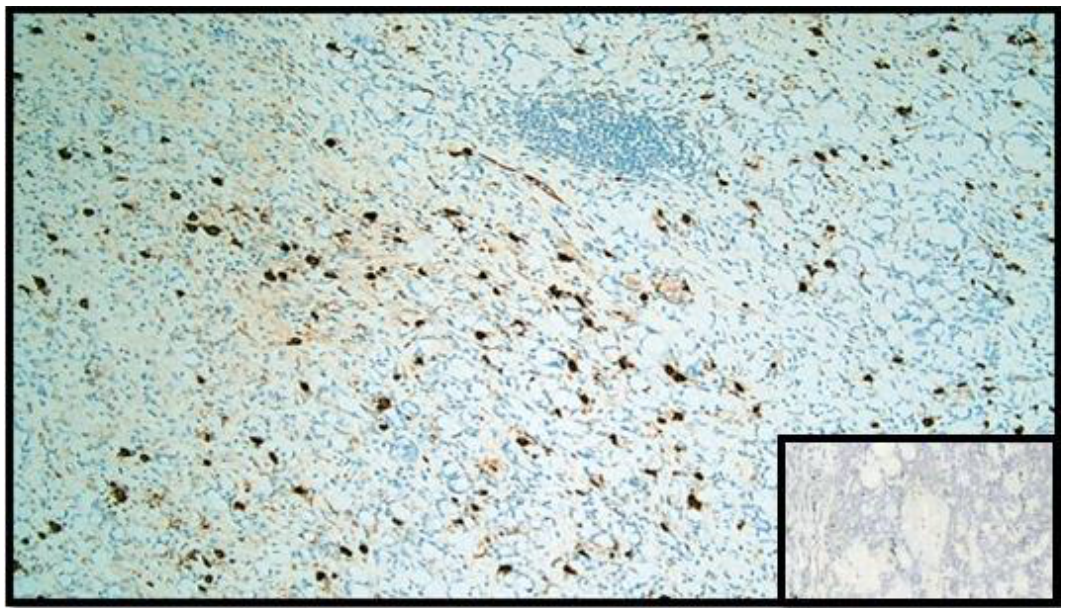
Figure 5. Immunohistochemical reaction with anti-chromogranin A antibody. Note the widespread positivity in the GCC component (IHC, original magnification: 20×). Box: negative control.